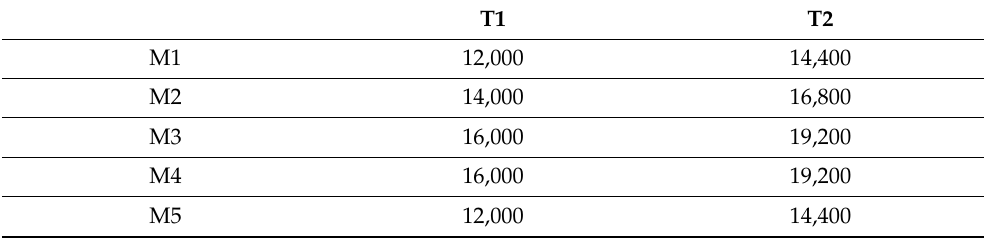
Table A4. Pellet demand in each market zone